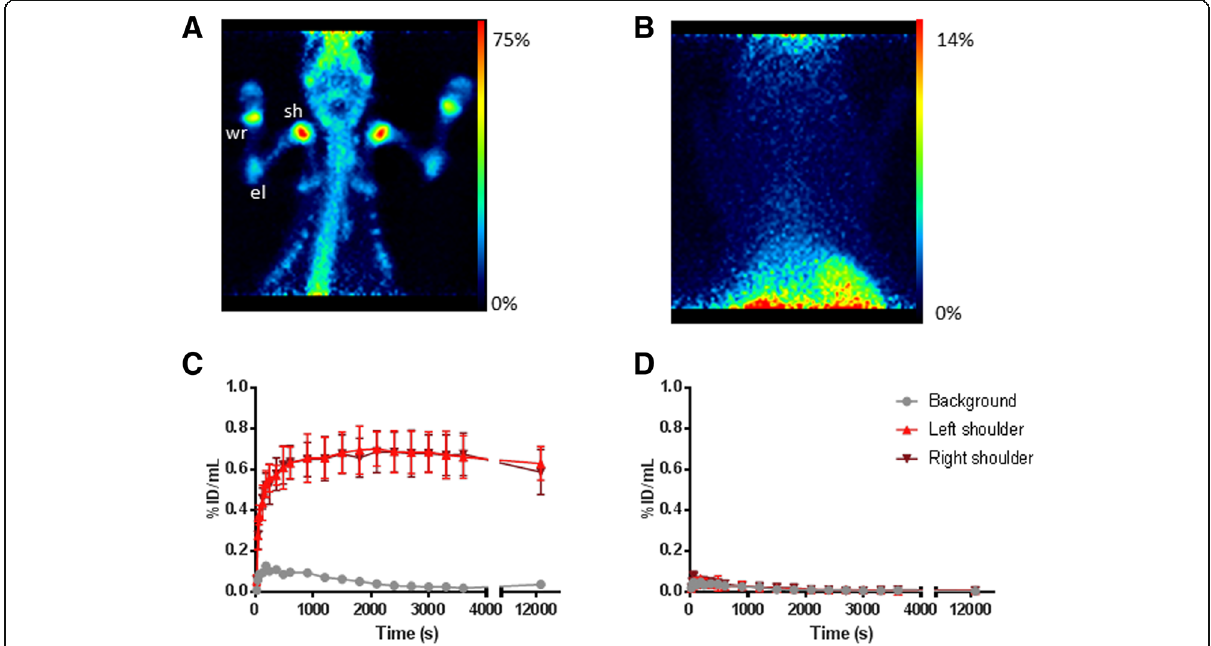
Fig. 2 PET analysis of [ 44 Sc] 3 in Wistar rats. a Maximum intensity projection (MIP) of rat administered with 2 1 h prior to administration of 12 MBq of [ 44 Sc] 3 , 4 h p.i of radioactivity; sh shoulder, el elbow, wr wrist. b MIP of rat administered with saline 1 h prior to administration of 12 MBq of [ 44 Sc] 3 , 4 h p.i. of radioactivity. c TAC of radioactivity uptake in the muscle (background grey circles), left shoulder (red triangles), and right shoulder (burgundy triangles) of rat pre-treated with 2 1 h prior to administering [ 44 Sc] 3 . d TAC of radioactivity uptake in the muscle (background grey circles) and left shoulder (red triangles) and right shoulder (burgundy triangles) of rat pre-treated with saline 1 h prior to administering [ 44 Sc] 3 . Three different ROIs were drawn for each shoulder to calculate the uptake value for the region